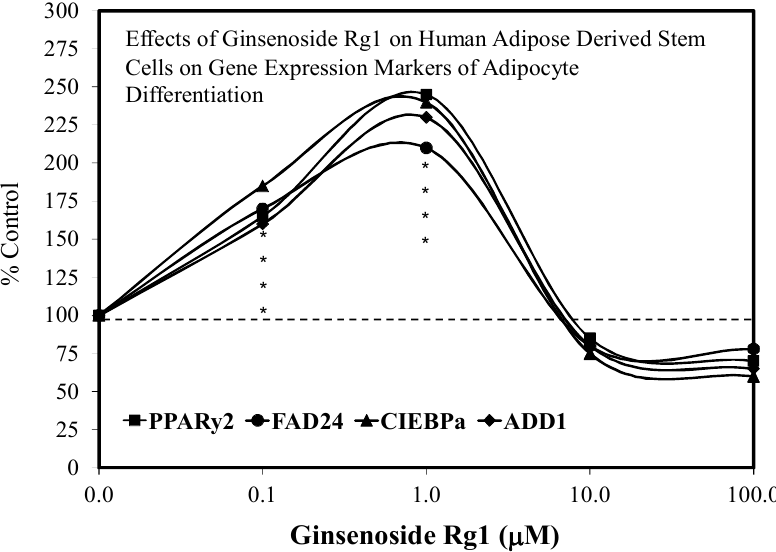
Figure 6. Effects of ginsenoside Rg1 on human adipose-derived stem cells on gene expression markers of adipocyte differentiation (source: [34]). Each * represent statistical significance for a data point.